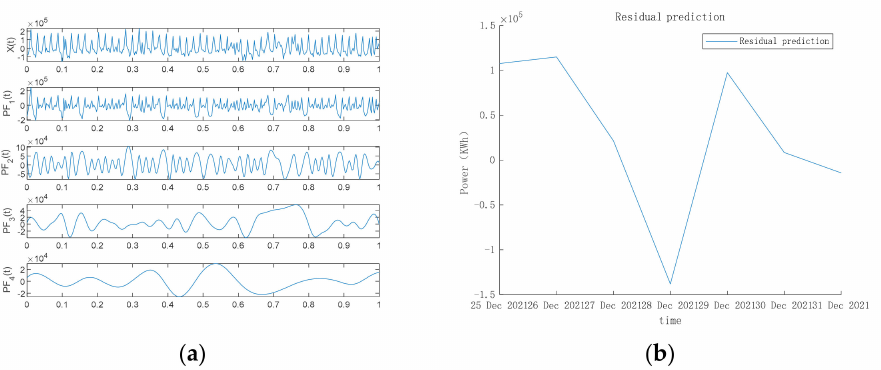
Figure 7. Output and residual prediction. ( a ) Each PF of the LSTM output; ( b ) Residual prediction.